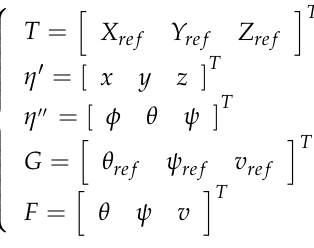
Figure 14. Block diagram of the proposed guidance and trajectory tracking with RLC.